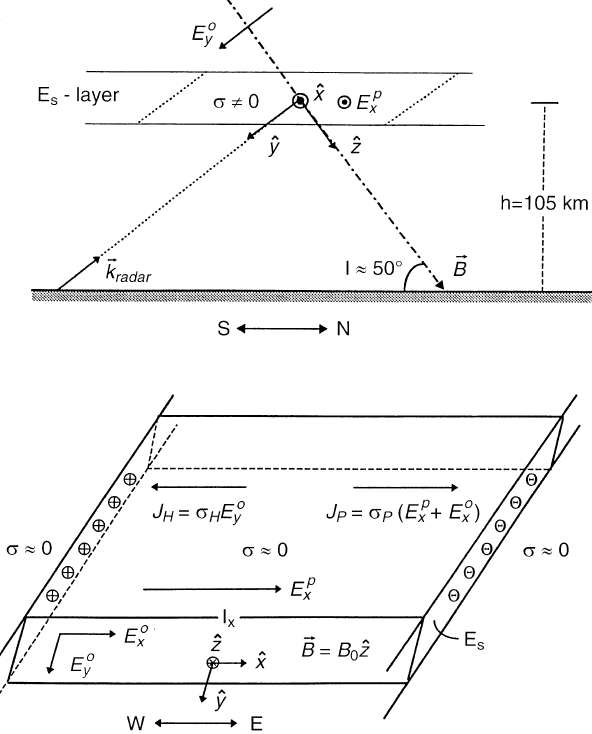
Fig. 9. A sketch of the proposed mid-latitude E s polarization process for the generation of large zonal electric fields, in the meridional ( top ) and the zonal ( bottom ) plane. As seen, a meridional electric field, E o in a plasma slab, leads to the generation of a stronger zonal polarization field as a result of the specific slab geometry and the anisotropy in conductivity in the plane perpendicular to the earth’s